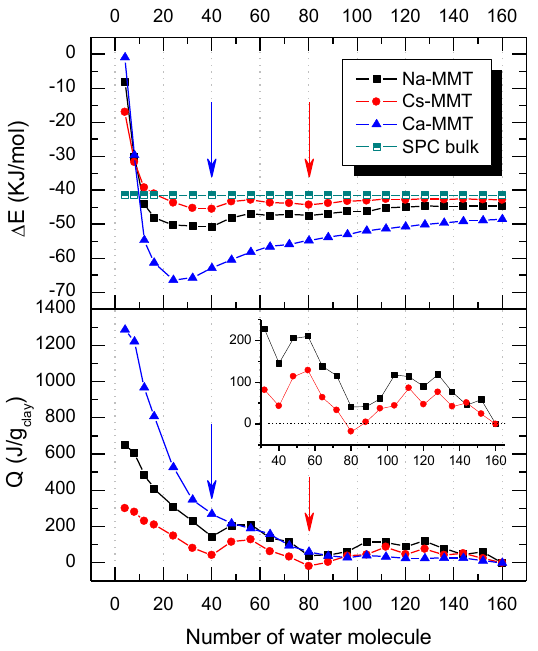
Figure 3. Hydration energy and immersion energy of montmorillonite as a function of increasing interlayer water molecule number.